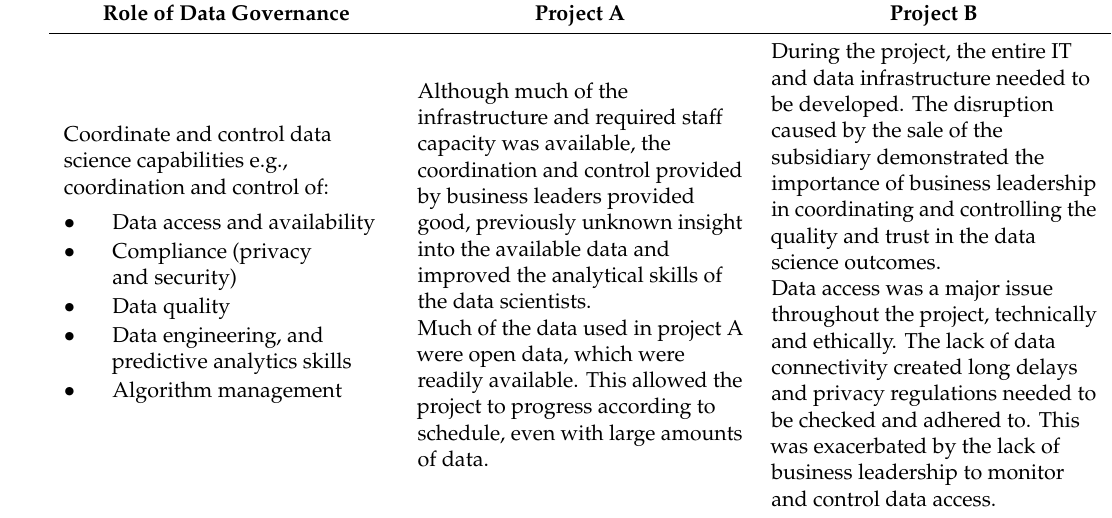
Table 3. Comparison of the cases with regards to the role of data governance in data science as a product of human